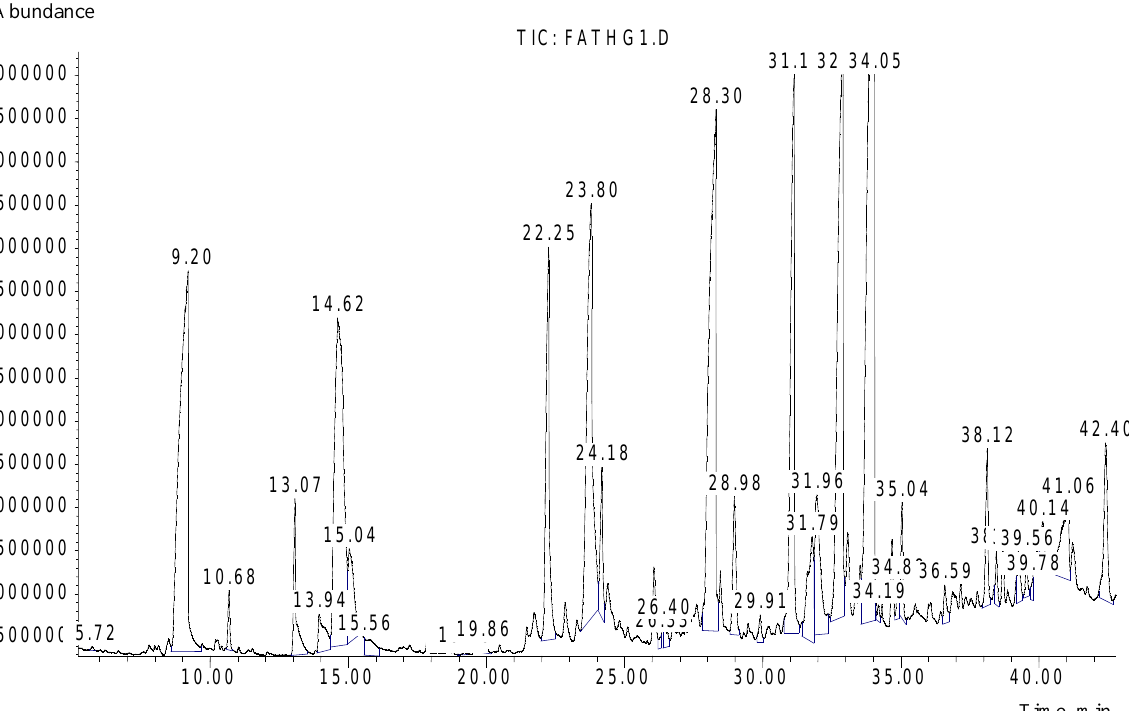
Fig. 5. Chromatographic profile of methyl esters of carboxylic acids of Veronica teucrium